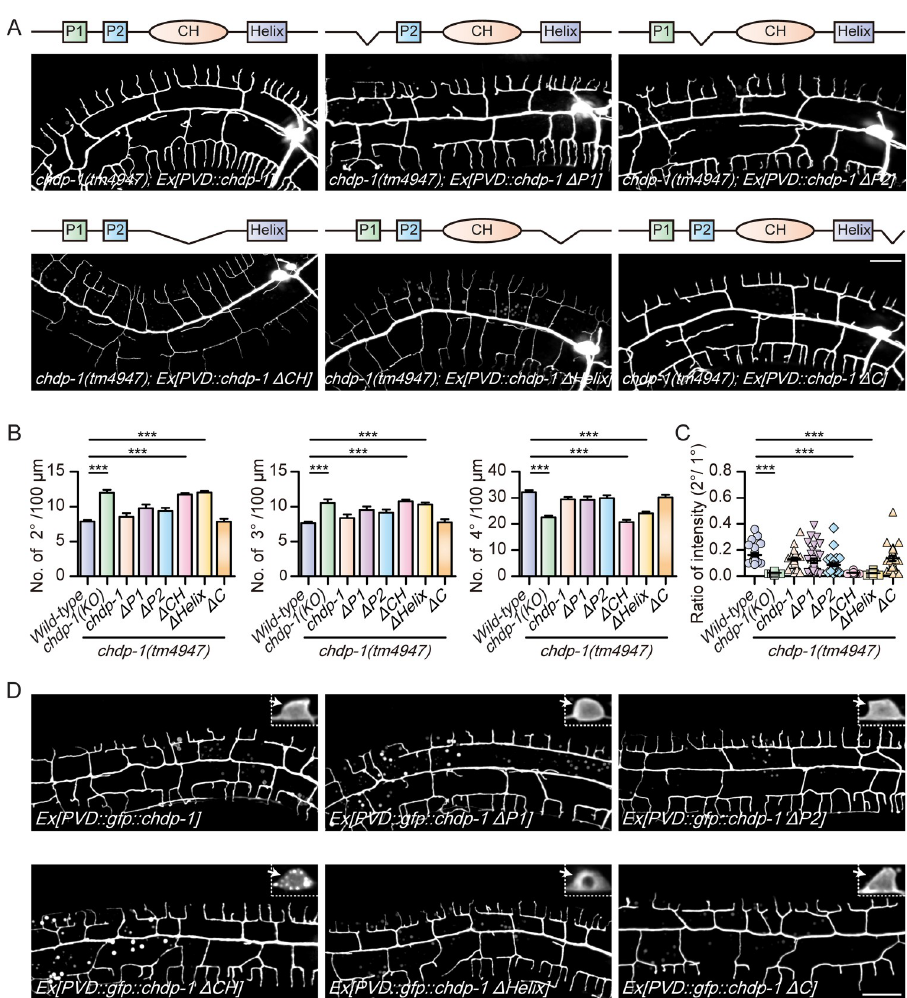
Fig 3. Structure-function analysis of CHDP-1 in dendrite development. (A) Confocal images showing the PVD morphologies of chdp-1(tm4947) mutant expressing full length CHDP-1, CHDP-1 Δ P1, CHDP-1 Δ P2, CHDP-1 Δ CH, CHDP-1 Δ Helix, CHDP-1 Δ C under the PVD specific promoter. Scale bar: 20 μ m. (B-C) Quantification of the number of (B) 2 o , 3 o and 4 o branches in a 100 μ m area anterior to the PVD cell body, and (C) the ratio of the intensity of the 2 o branches to that of the primary dendrites in wild-type , chdp-1(tm4947) and chdp-1(tm4947) mutant expressing either full length or truncated forms of CHDP-1. Error bars: SEM. ��� p < 0.001 by one-way ANOVA with the Tukey correction. n = 20–30 for each genotype. (D) Confocal images showing the localization of GFP::CHDP-1 (full length), GFP::CHDP-1 Δ P1, GFP::CHDP-1 Δ P2, GFP::CHDP-1 Δ CH, GFP::CHDP-1 Δ Helix and GFP::CHDP-1 Δ C under the PVD specific promoter ( ser2rpom3 ). Arrows: the localization of CHDP-1 and truncated CHDP-1 in PVD cell body. Scale bar: 20 μ m.